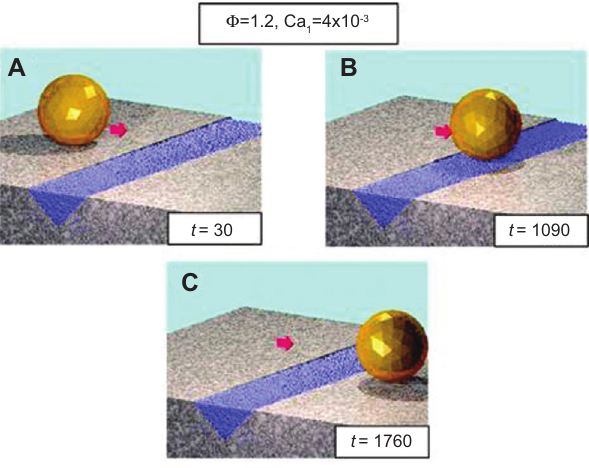
Figure 18 Movement of the microcapsule over the surface with a completely nanoparticle-filled crack (reprinted with permission from